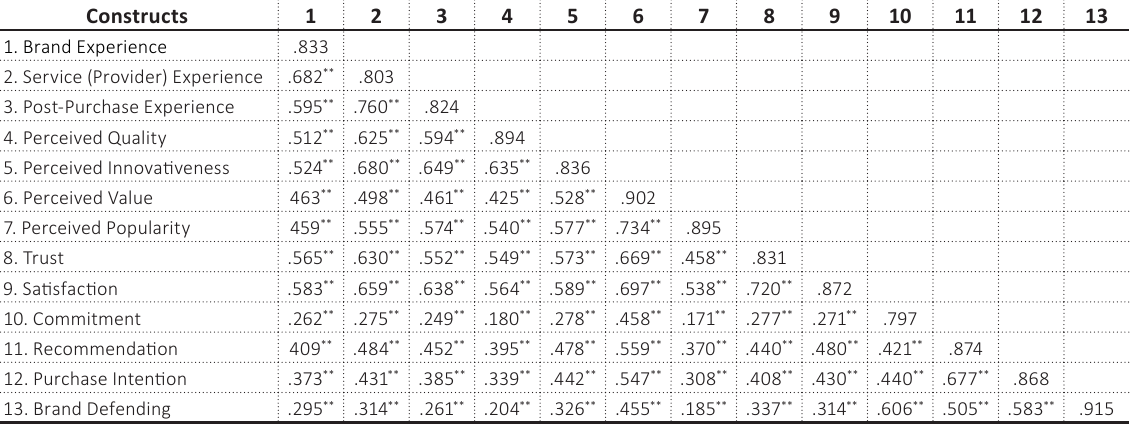
Table 1. Discriminant validity assessment Constructs